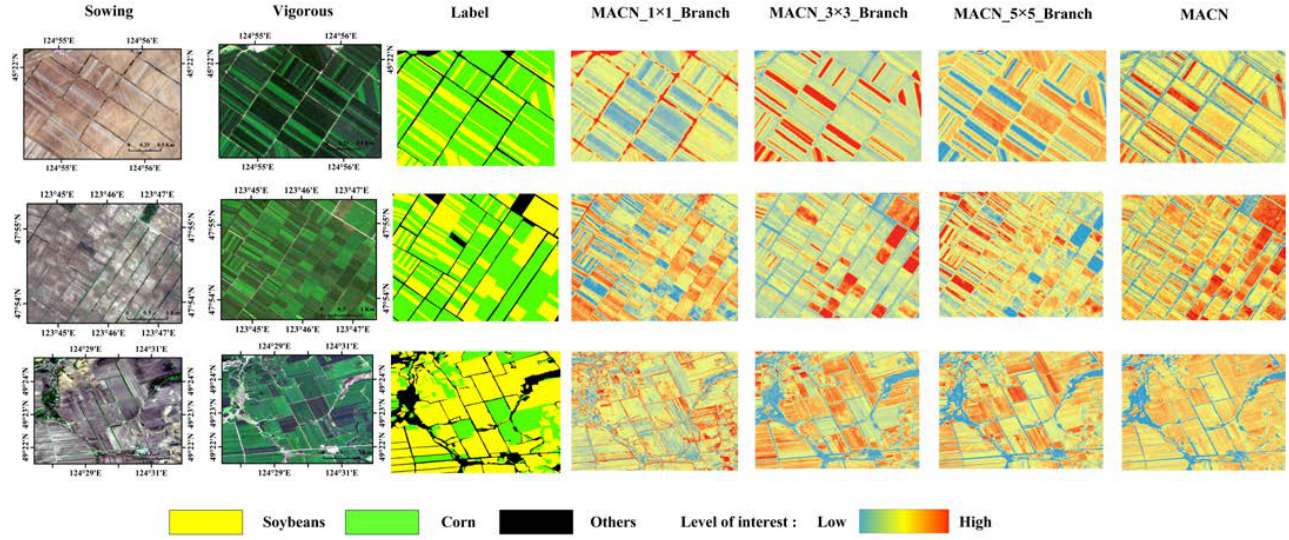
Figure 12. The feature maps of the three branches of MACN.